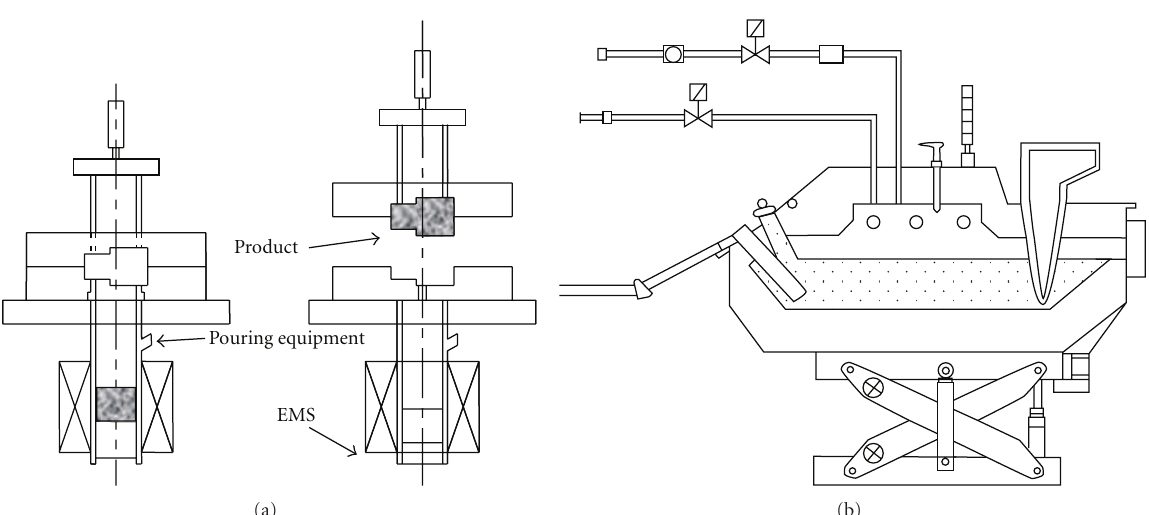
Figure 5: Hotspot distribution of arm part and heating line.